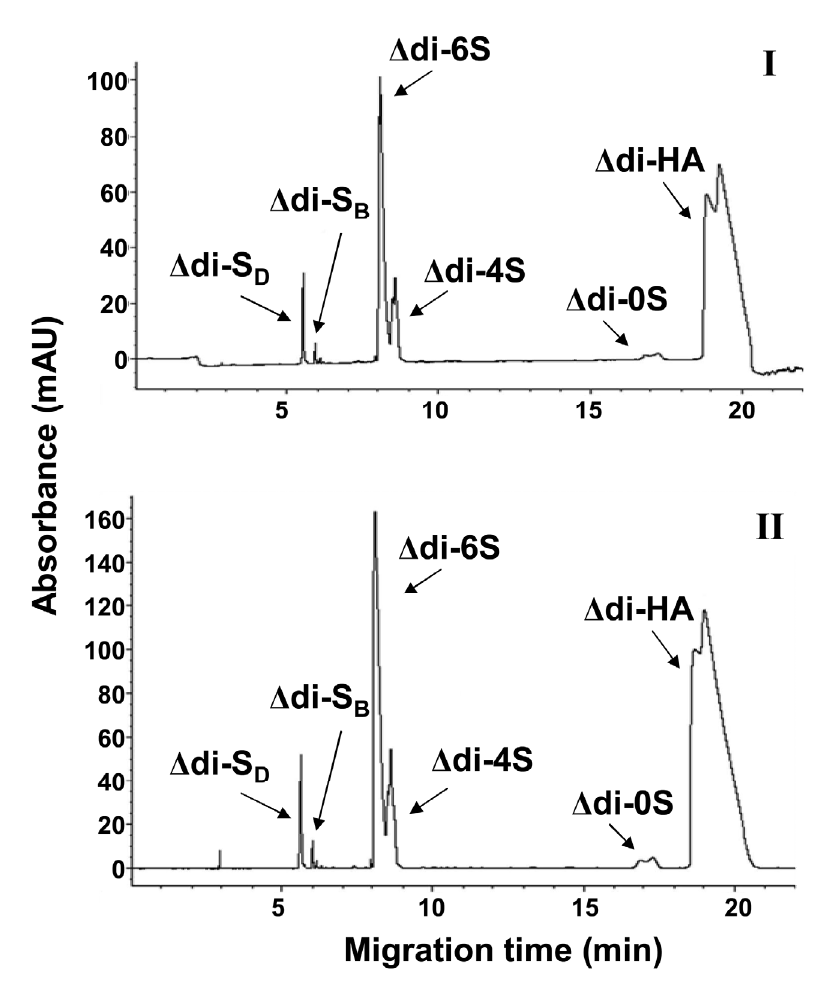
, Δ di-S , Δ di-6S, Δ di-4S, D B